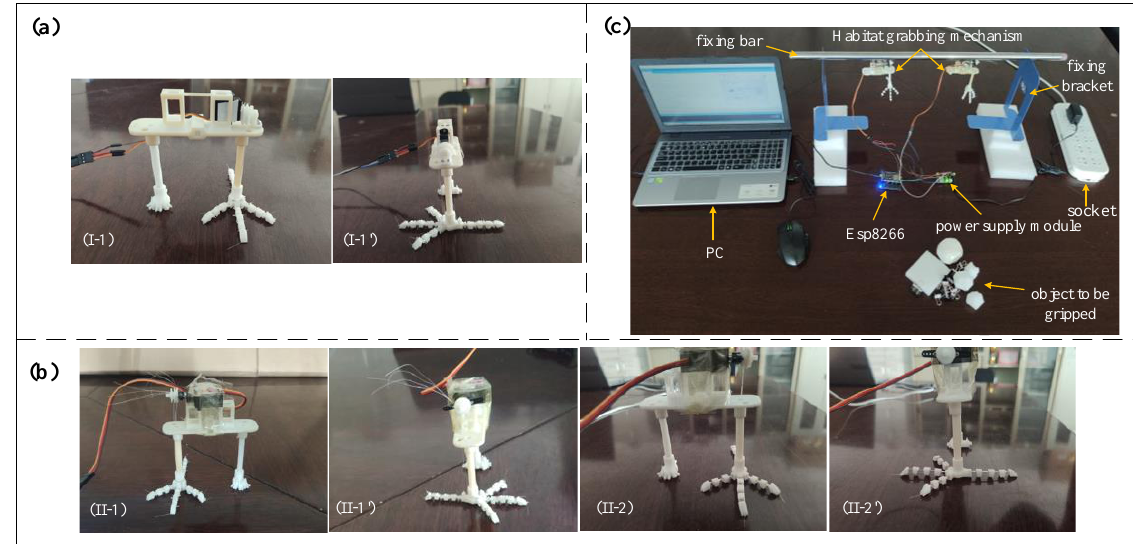
Figure 7. Fabrication of the prototype and the experiment platform. ( a ) First generation of articulated perch gripping mechanism prototype, (I-1) front view, (I-1 ′ ) side view. ( b ) Second generation of two perch gripping mechanism prototypes, (II-1) articulated front view, (II-1 ′ ) articulated side view, (II-2) resilient reset front view, (II-2 ′ ) resilient reset side view. ( c ) The experiment platform.